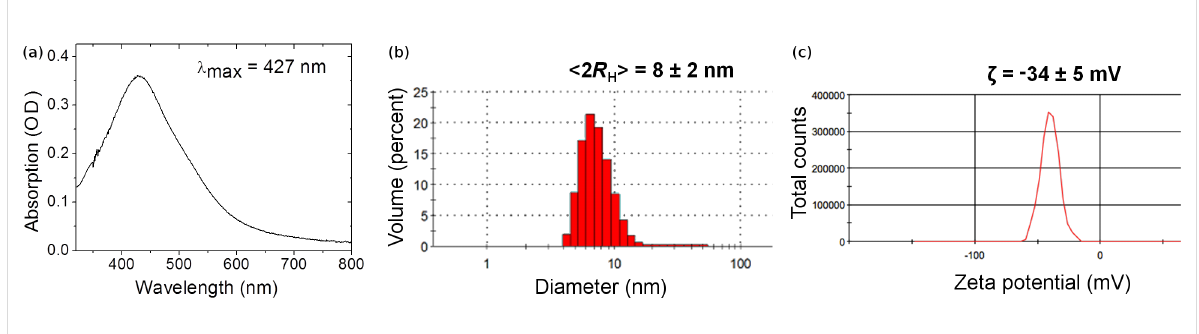
Figure 1: Characterization of AgNP-3MPS nanoparticles in H 2 O (synthesis a): (a) UV–vis spectrum; (b) DLS measurements: <2 R H > = 8 ± 2 nm; (c) ζ -potential measurements: ζ = − 34 ± 5 mV.